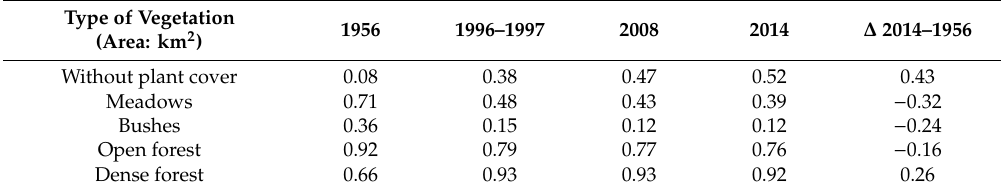
Figure 5. Google earth image (2008) of the headwaters, where the Port Ain é ski resort is located. Impact on vegetation is clearly visible. Table 5. Areas corresponding to the di ff erent types of vegetation and areas without vegetation calculated from the headwater maps (Portain é and Reguerals bsubbasins) and their increments (examples in Figure S7). ∆ expressing